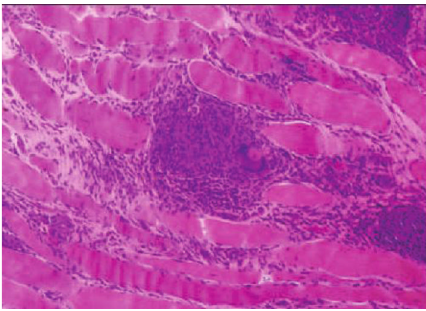
Figure 3: Muscle biopsy of a patient with sarcoid myopathy demon- strates fascicular inflammatory infiltrates with multinucleate giant